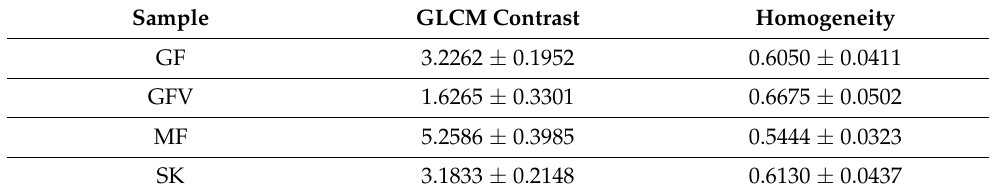
Table 2. GLCM parameters, homogeneity and contrast, for all chocolate samples tested.